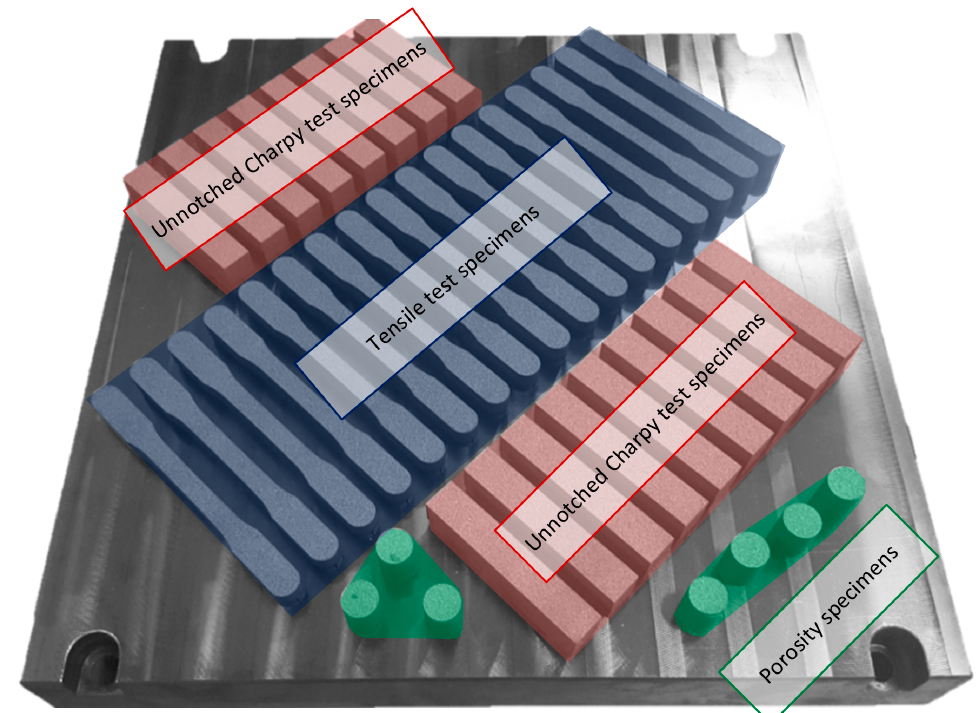
Figure 3. Building plate with printed specimens.